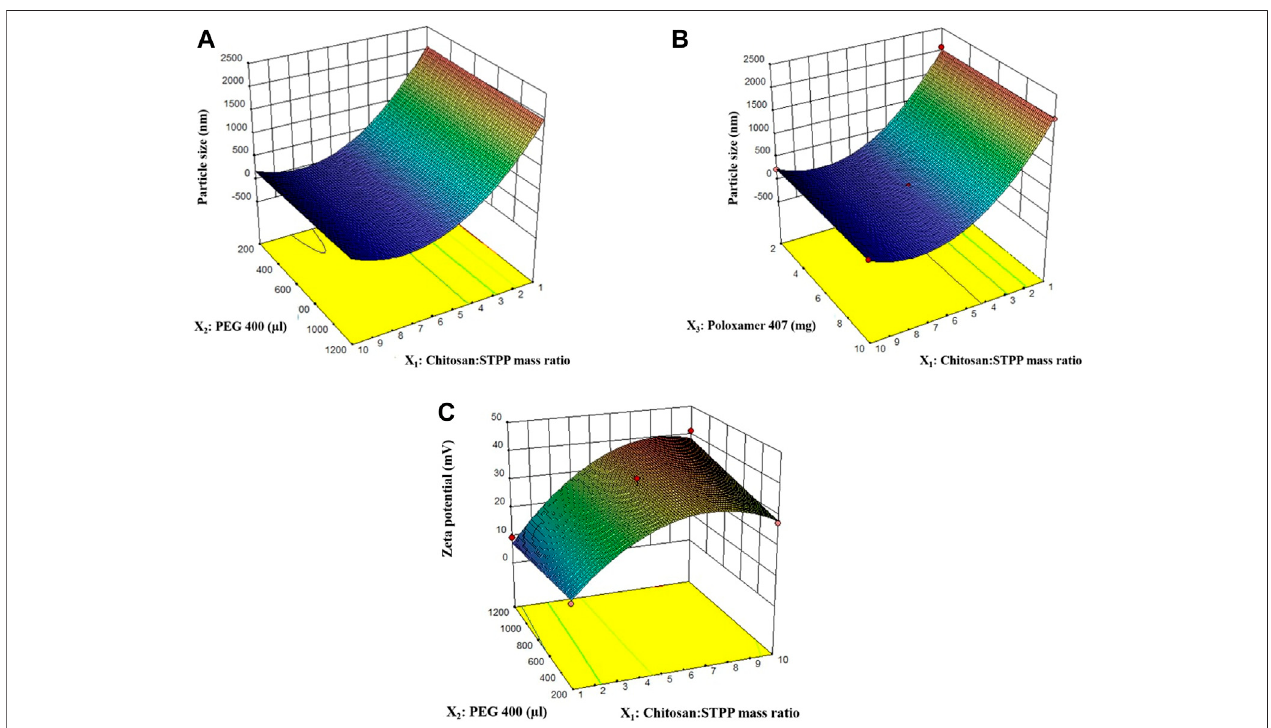
FIGURE 1 | 3D response surface plots for effect of factors on particle size (A, B) , and zeta potential (C) .